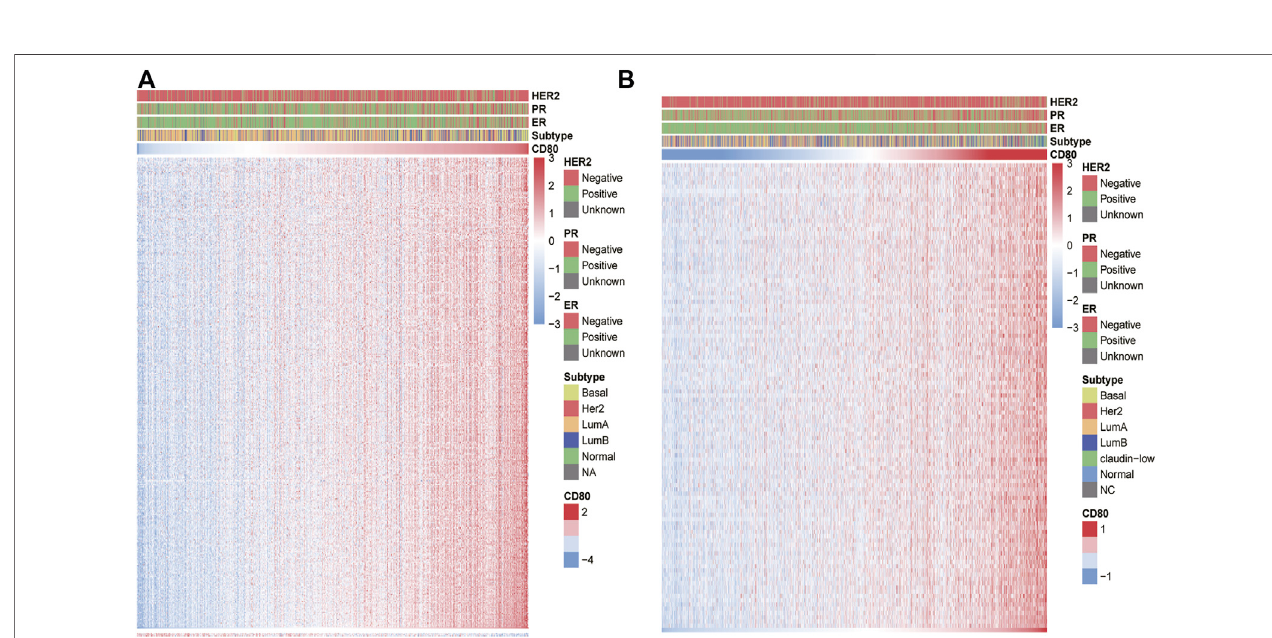
FIGURE 4 | CD80-related immune responses. Most immune-related genes are positively correlated with the CD80 expression in the TCGA and METABRIC databases, while few genes are negatively associated (A,B) .